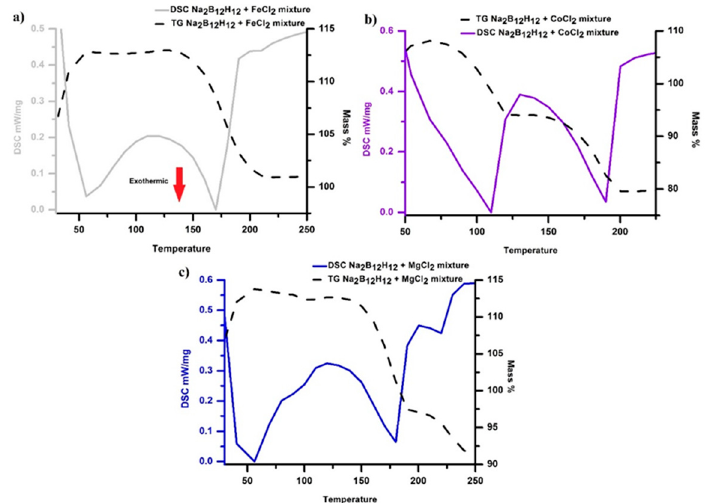
Figure 2. DSC/TG heating curves for ball-milled and solvated with methanol ( a ) Na 2 B 12 H 12 + FeCl 2 , ( b ) Na 2 B 12 H 12 + CoCl 2 and ( c ) Na 2 B 12 H 12 + MgCl 2 mixtures. The samples were loaded in an open